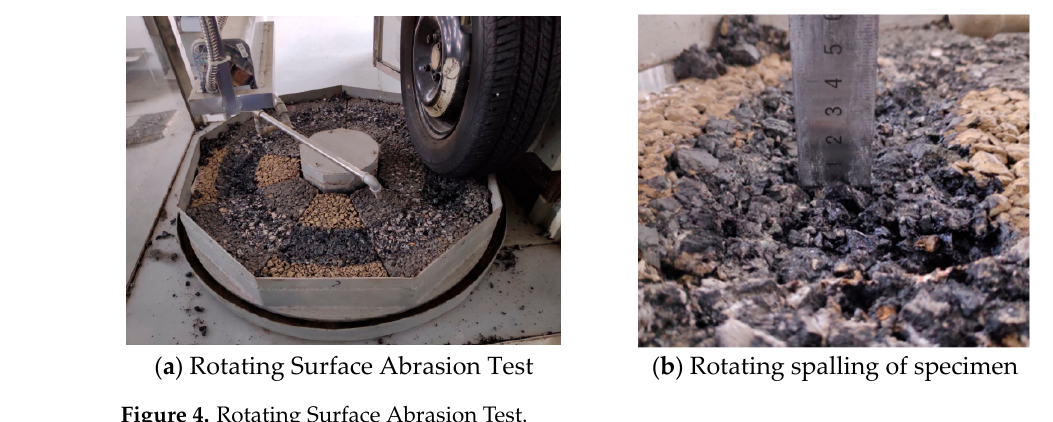
Figure 4. Rotating Surface Abrasion Test.